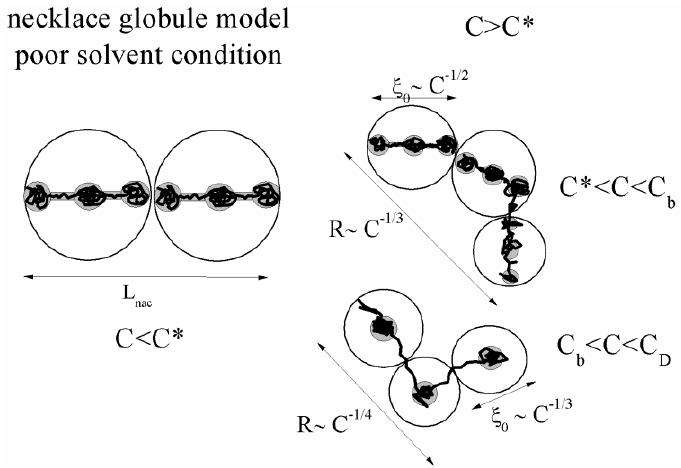
) and bead controlled regime ( C b